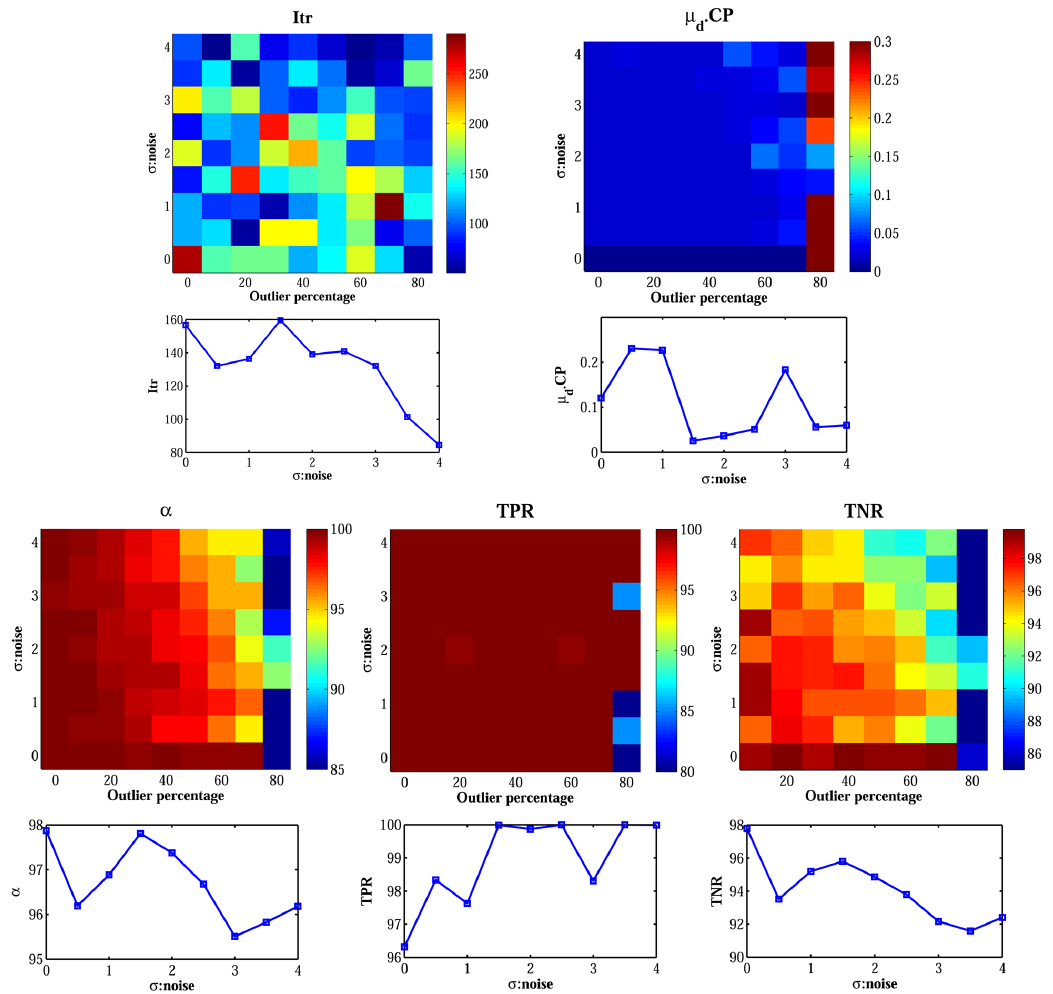
Figure 9. Performance of the proposed algorithm with noisy images. The graph at the bottom of each surface-plot represents the average of respective performance criterion versus the amount of